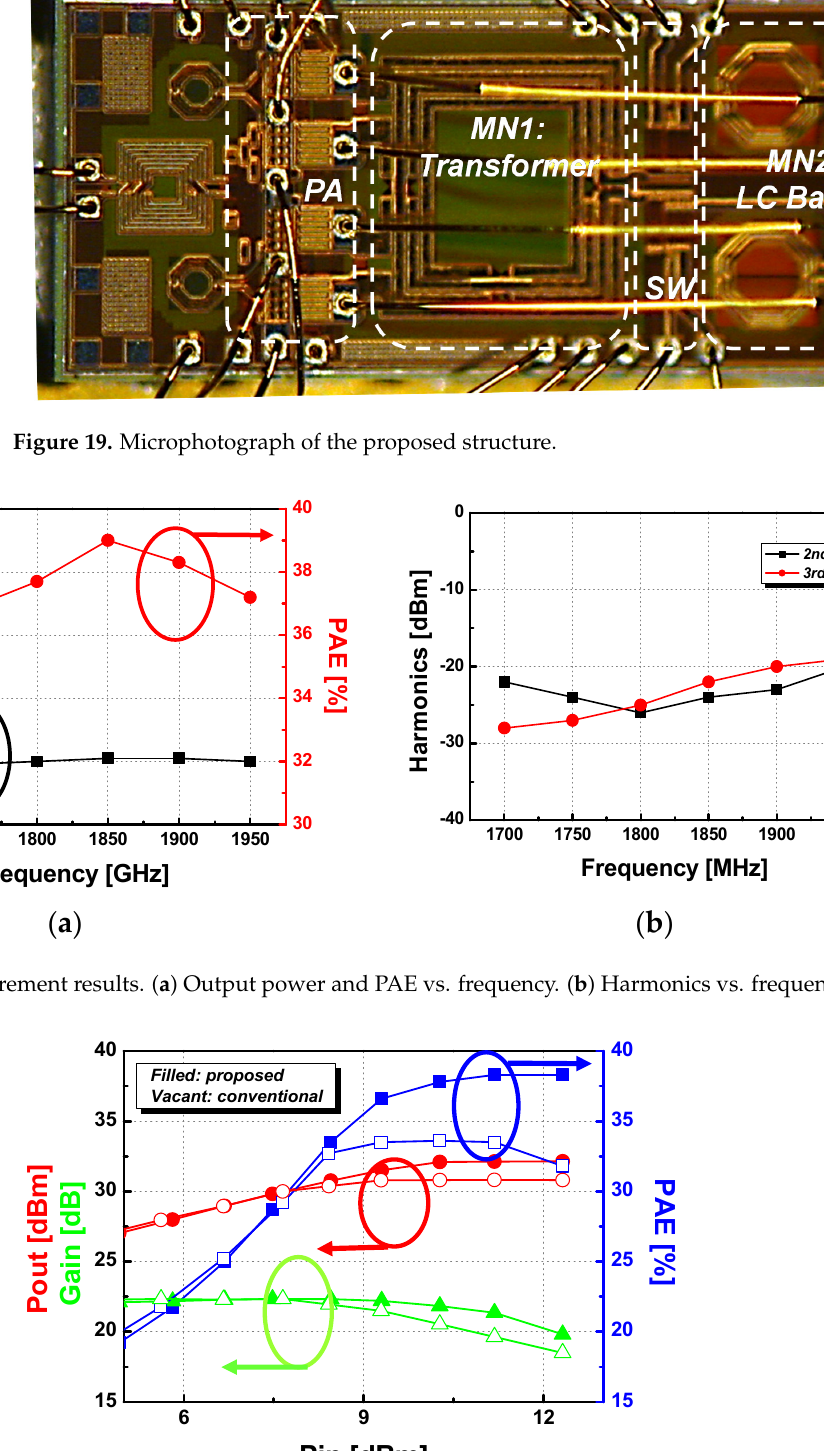
Figure 21. Compared measurement results of output power and PAE over various input power.